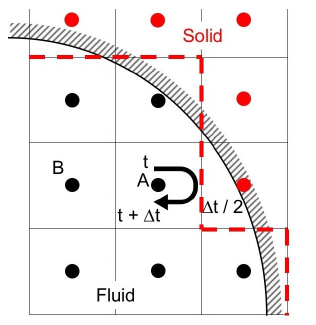
Figure 1. Half-way bounce-back